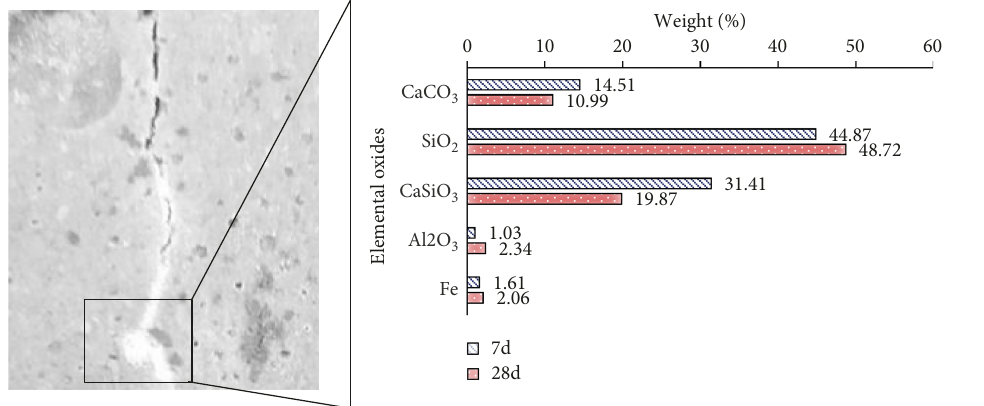
Figure 7: EDX spectrum of extracted powder out of healed crack in LSP-B